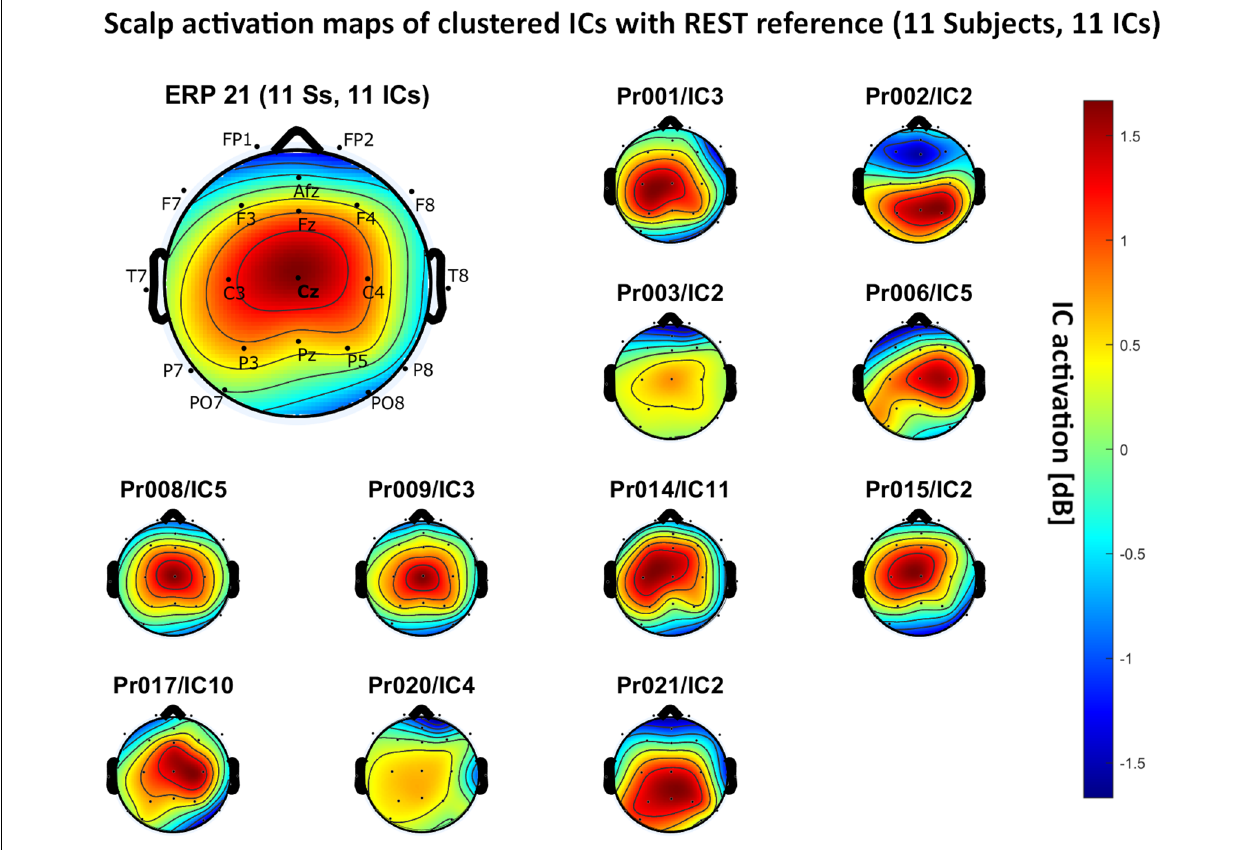
FIGURE 7 | Scalp activation for the selected ICs for 11 subjects with REST as a referencing technique. The color-coding indicates the activation of the components in dB. The average activation is plotted in the top-left corner, including detailed electrode